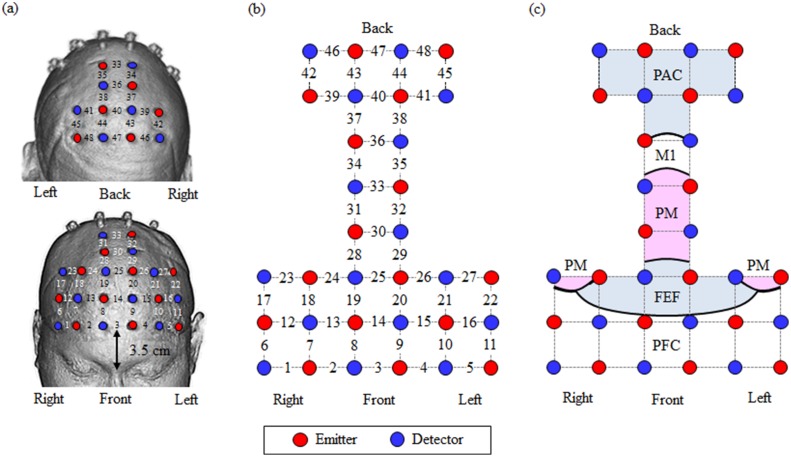
Relationship between channel configuration / probe placement and the underlying brain sites.(a) Probes mounted on the head. (b) Probe arrangement and measurement channel numbers. (c) Relationship between brain regions and measurement channels were confirmed using MRI. PFC: prefrontal cortex (including superior and middle frontal gyrus). PAC = parietal association cortex, M1 = primary motor cortex, PM = premotor cortex, FEF = frontal eye field, and PFC = prefrontal cortex.